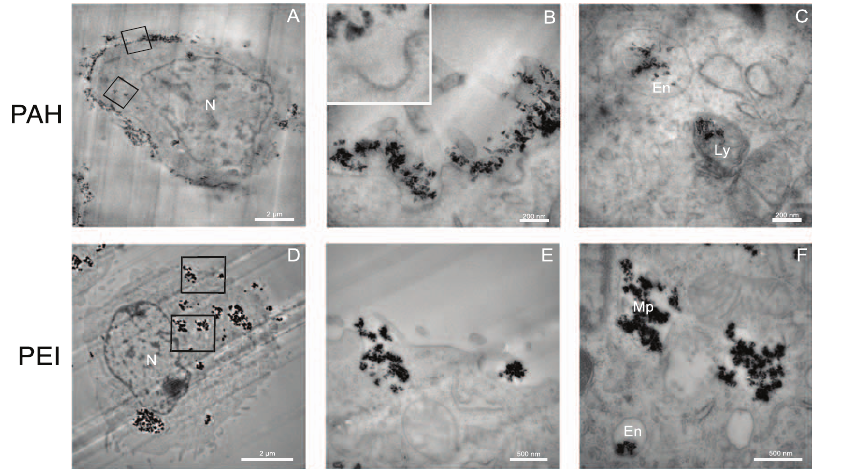
Figure 3. TEM observations of the distribution in NIH/3T3 EWS-Fli1 cells of ND-PAH (A)–(C) and ND-PEI (D)–(F) after 4 h of incubation. N: cell nucleus, En: endosomal compartment, Ly: lysosomal compartment, Mp: macropinosome compartment. (A) Most of ND-PAH are located on the outside of the cell membrane. (B) Higher magnification of the cell membrane (upper square-delimited region of (A)) displaying invaginations around aggregates of ND-PAH, an early stage in clathrin-mediated endocytosis. Inset: Higher magnification showing the clathrin pits, perpendicular to the invaginated membrane. (C) Magnification corresponding to the lower square-delimited region in (A), showing ND-PAH located in endosomal (En) and lysosomal (Ly) vesicles. (D) Most of the ND-PEI are present within the cell, in large structures in the perinuclear region. (E) Magnification corresponding to the upper square-delimited region in (D) showing pseudopods formed at the cell membrane during ND-PEI uptake. (F) Magnification corresponding to the lower square-delimited region in (D), showing ND-PEI localization, mostly in large macropinosome (Mp) vesicles, but also, to some extent, in endosomes (En). Scale bars in (A) and (D): 2 m m and in (B), (C), (E) and (F): 200 nm. TEM magnification in (A) and (D): 6 4,400; in (B) and (C): 6 50,000; in (E): 6 20,000, and in (F): 6 30,000.